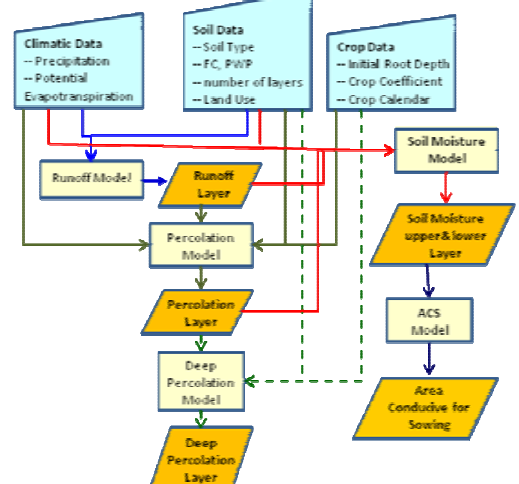
Figure 1: Overview of the soil water balance